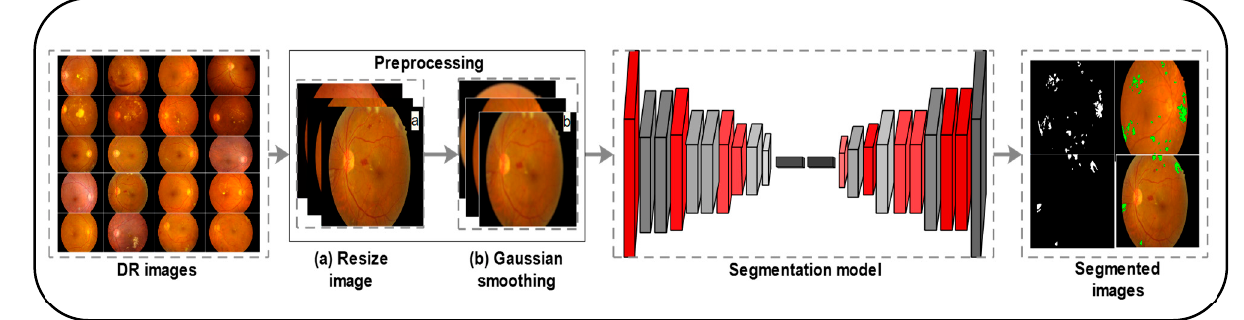
Figure 6. Segmentation process for DR [10].